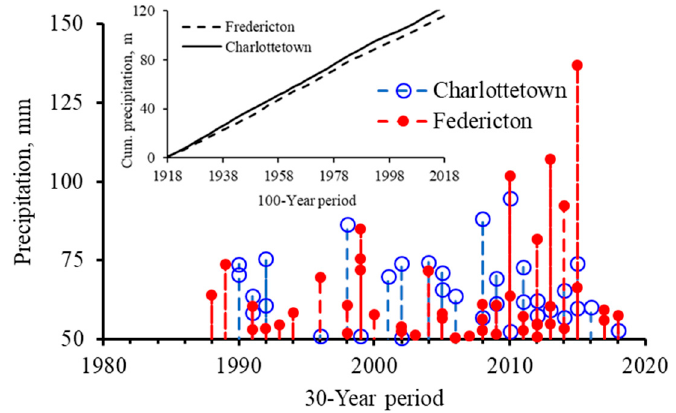
Figure 4. Amount of daily precipitation exceeding 50 mm in Fredericton and Charlottetown during the 1988–1918 period. The solid red or blue lines represent more than one event of above 50 mm precipitation during the same year. The open circle symbols for Charlottetown data have been enlarged to avoid hiding of Fredericton data. The inset black and white graph shows cumulated 100-year precipitation to display that Charlottetown (solid black line) received more total precipitation than Fredericton (broken black line).